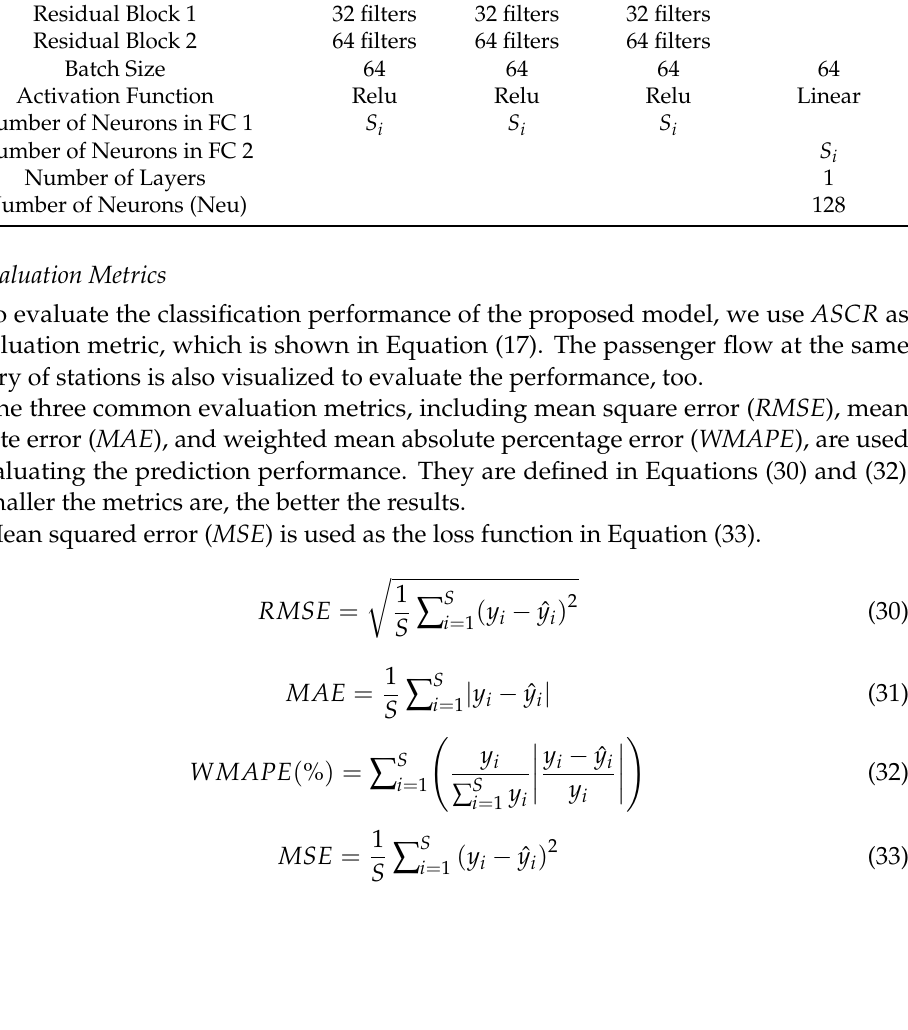
Table 3. Parameters used in the prediction block. Parameters Inflow Outflow